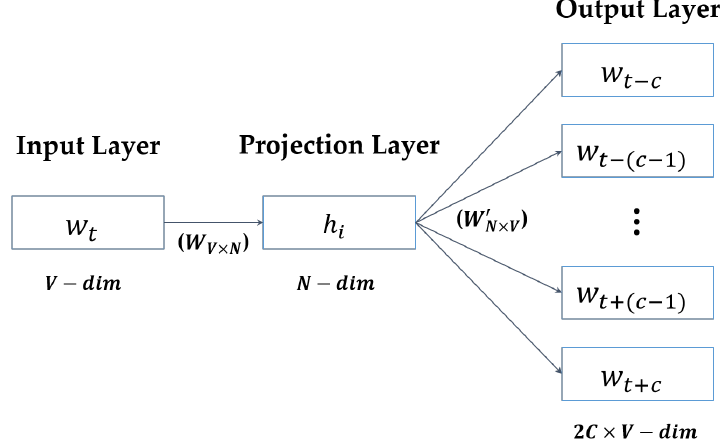
Figure 3. The Skip-Gram model